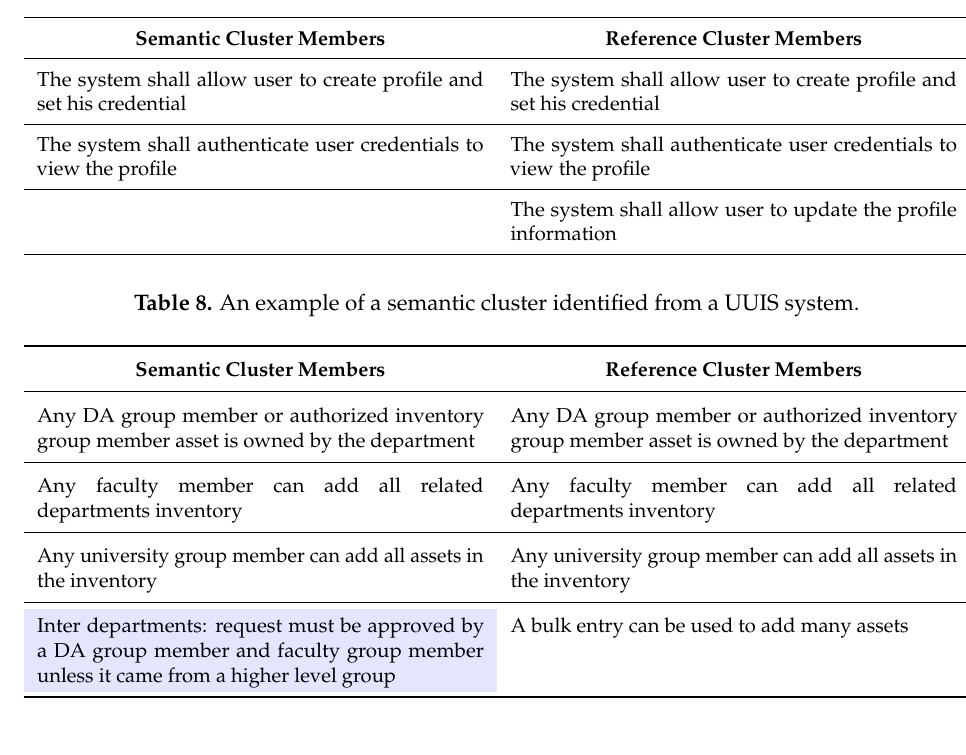
Table 7. An example of a semantic cluster identified from an E-Store System.